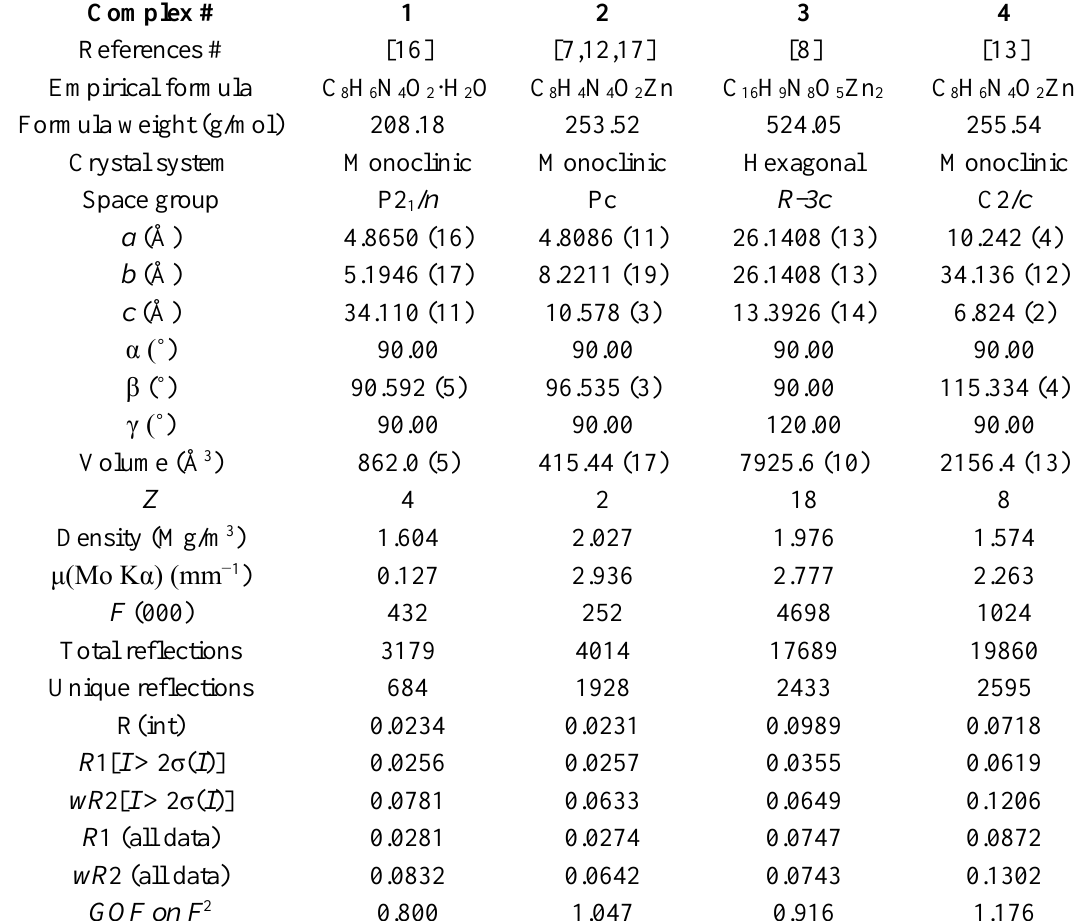
Table 1. Crystallographic data and structural refinement summary for complexes 1 to 4